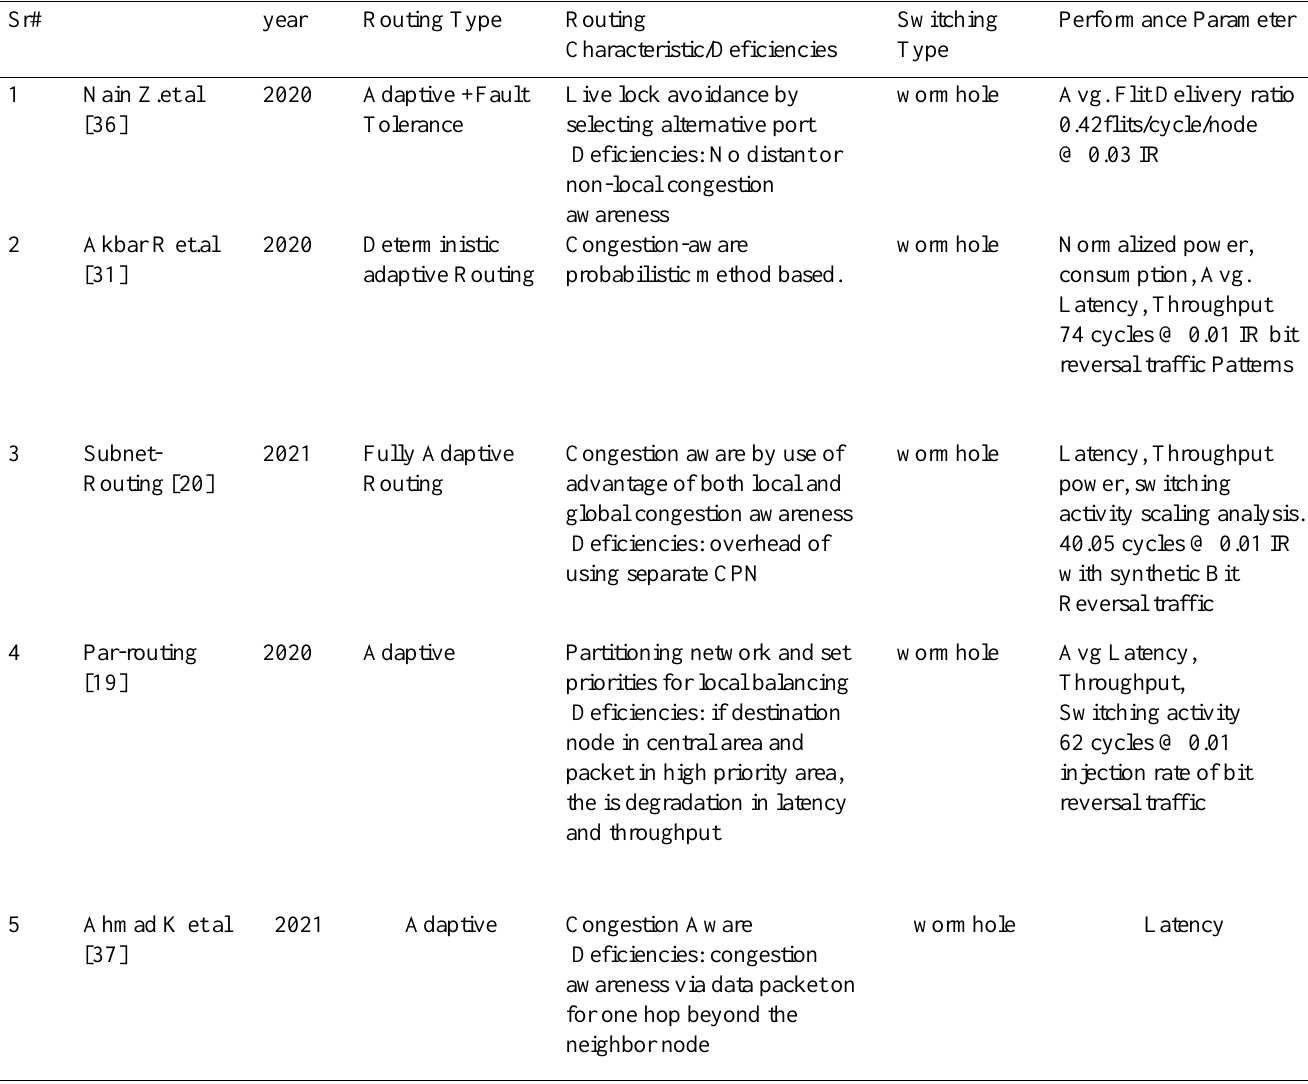
Summary of Cutting-edge research papers having deficiencies, routing technique and performance parameter